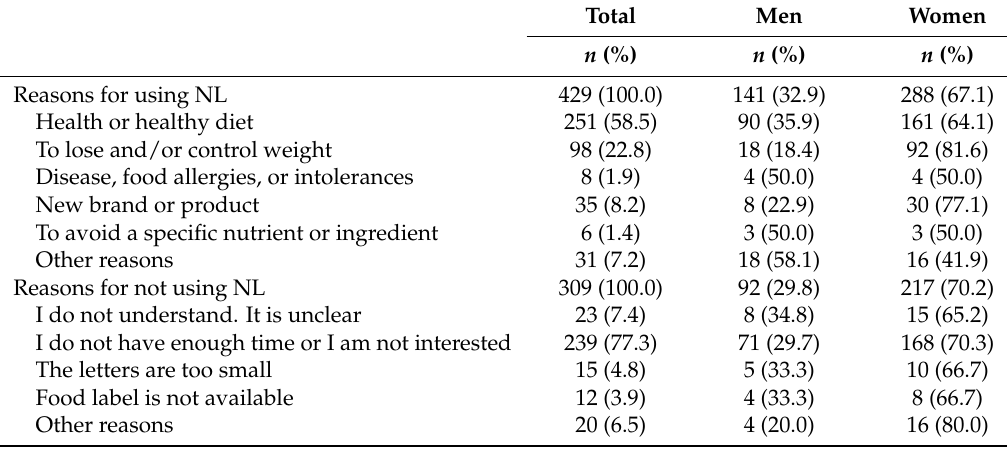
Table 2. Reasons for using or not using nutrition labelling given by students from the DiSA-UMH study, Spain ( n = 738). NL, nutrition